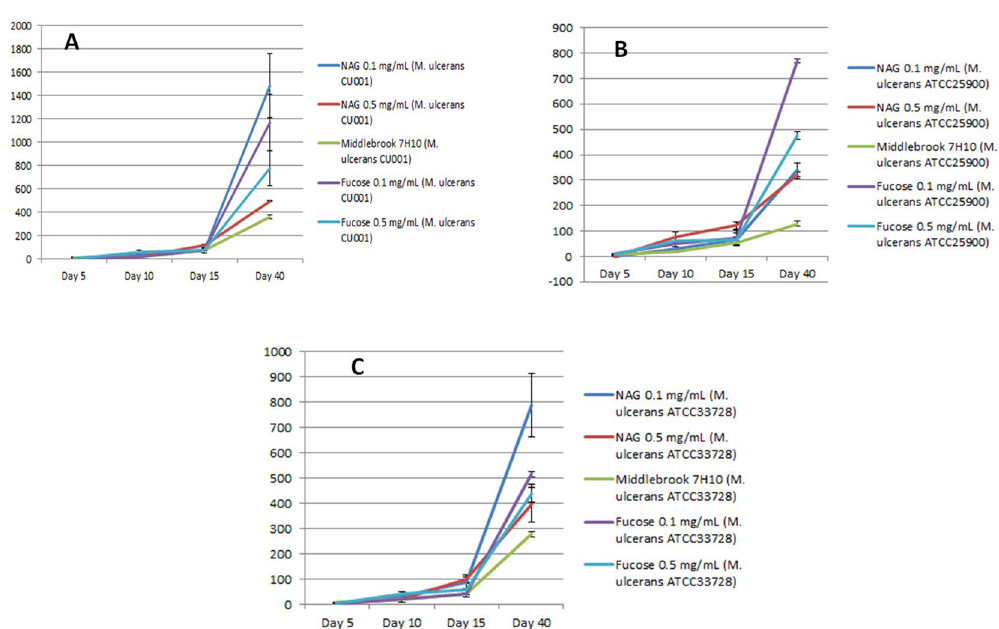
Figure 2. Growth of M. ulcerans (10 4 bacilli) onto Middlebrook 7H10 enriched with high concentration of N-acethyl galactosamine (0.1 mg/mL, 0.5 mg/mL) and fucose (0.1 mg/mL, 0.5 ( A ). M. ulcerans CU001; ( B ) M. ulcerans ATCC25900; ( C ) M. ulcerans